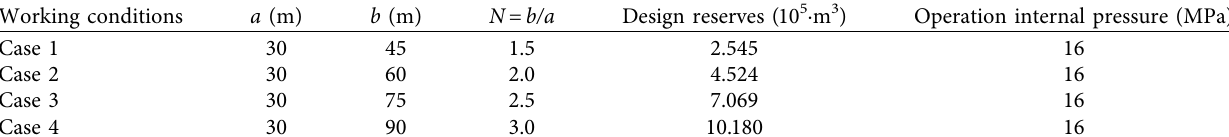
Table 2: Model parameters of single-cavern horizontal salt rock underground storage.